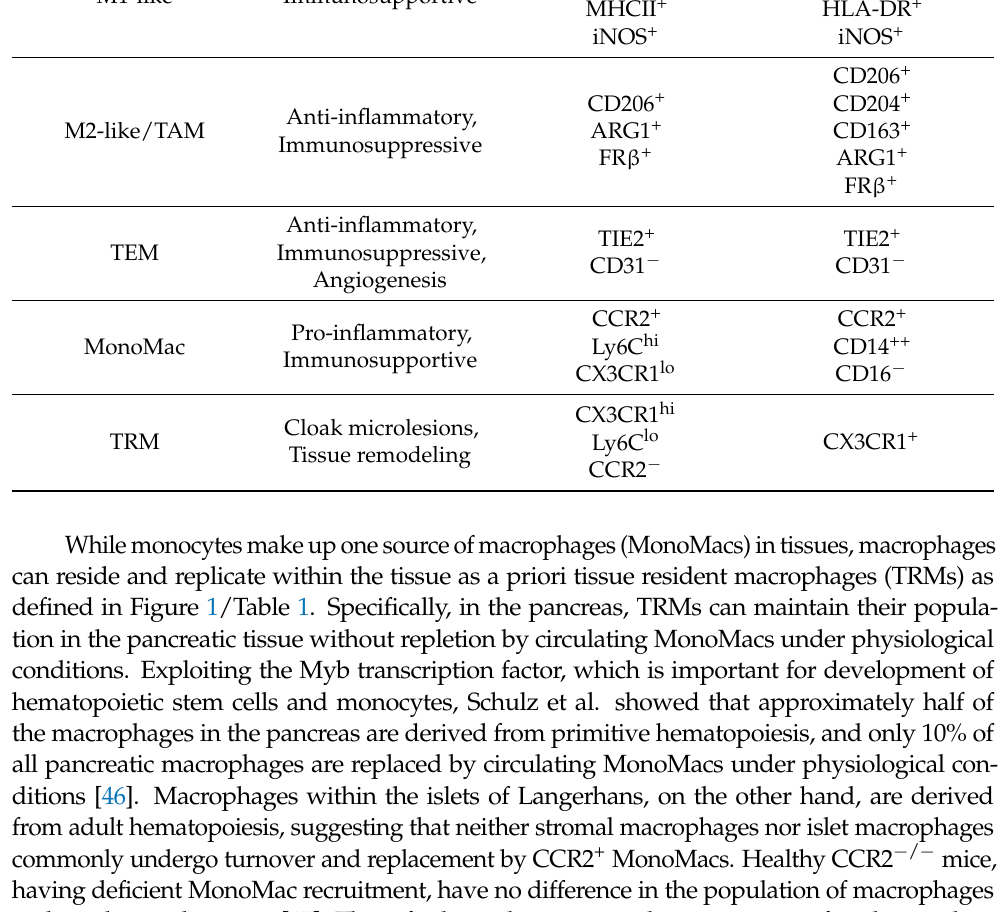
Table 1. Characterization of macrophage subtypes by function and markers. This table does not include pan-macrophage markers, such as CD11b (Myeloid lineage marker), F4/80 (Murine), and CD68 (Human). Macrophage Function Murine Markers Human Markers Subtype CD80 + CD80 + CD86 + CD86 + M1-like Immunosupportive MHCII + HLA-DR + iNOS + iNOS + CD206 + CD204 + CD163 Immunosuppressive